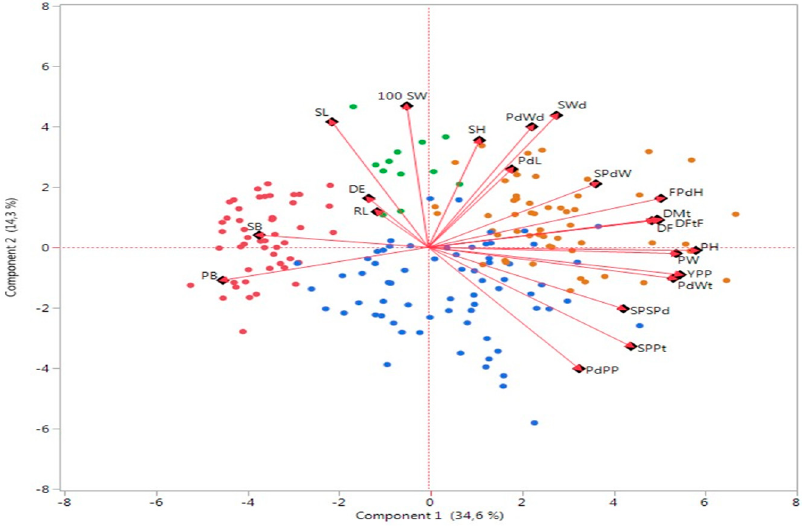
Figure 6. Genotype × trait biplots of Turkish common bean germplasm under five environments